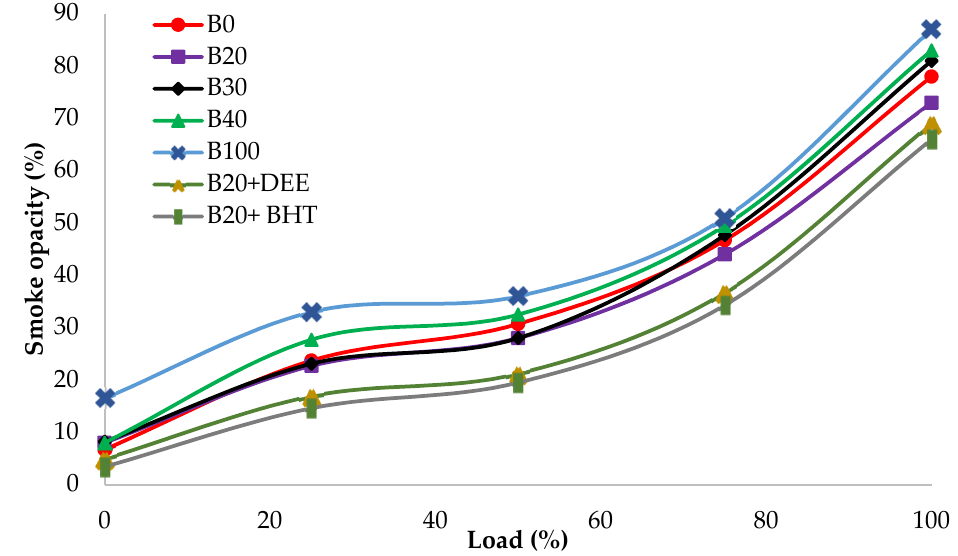
Figure 13. Smoke opacity of all fuel blends at different engine loads.